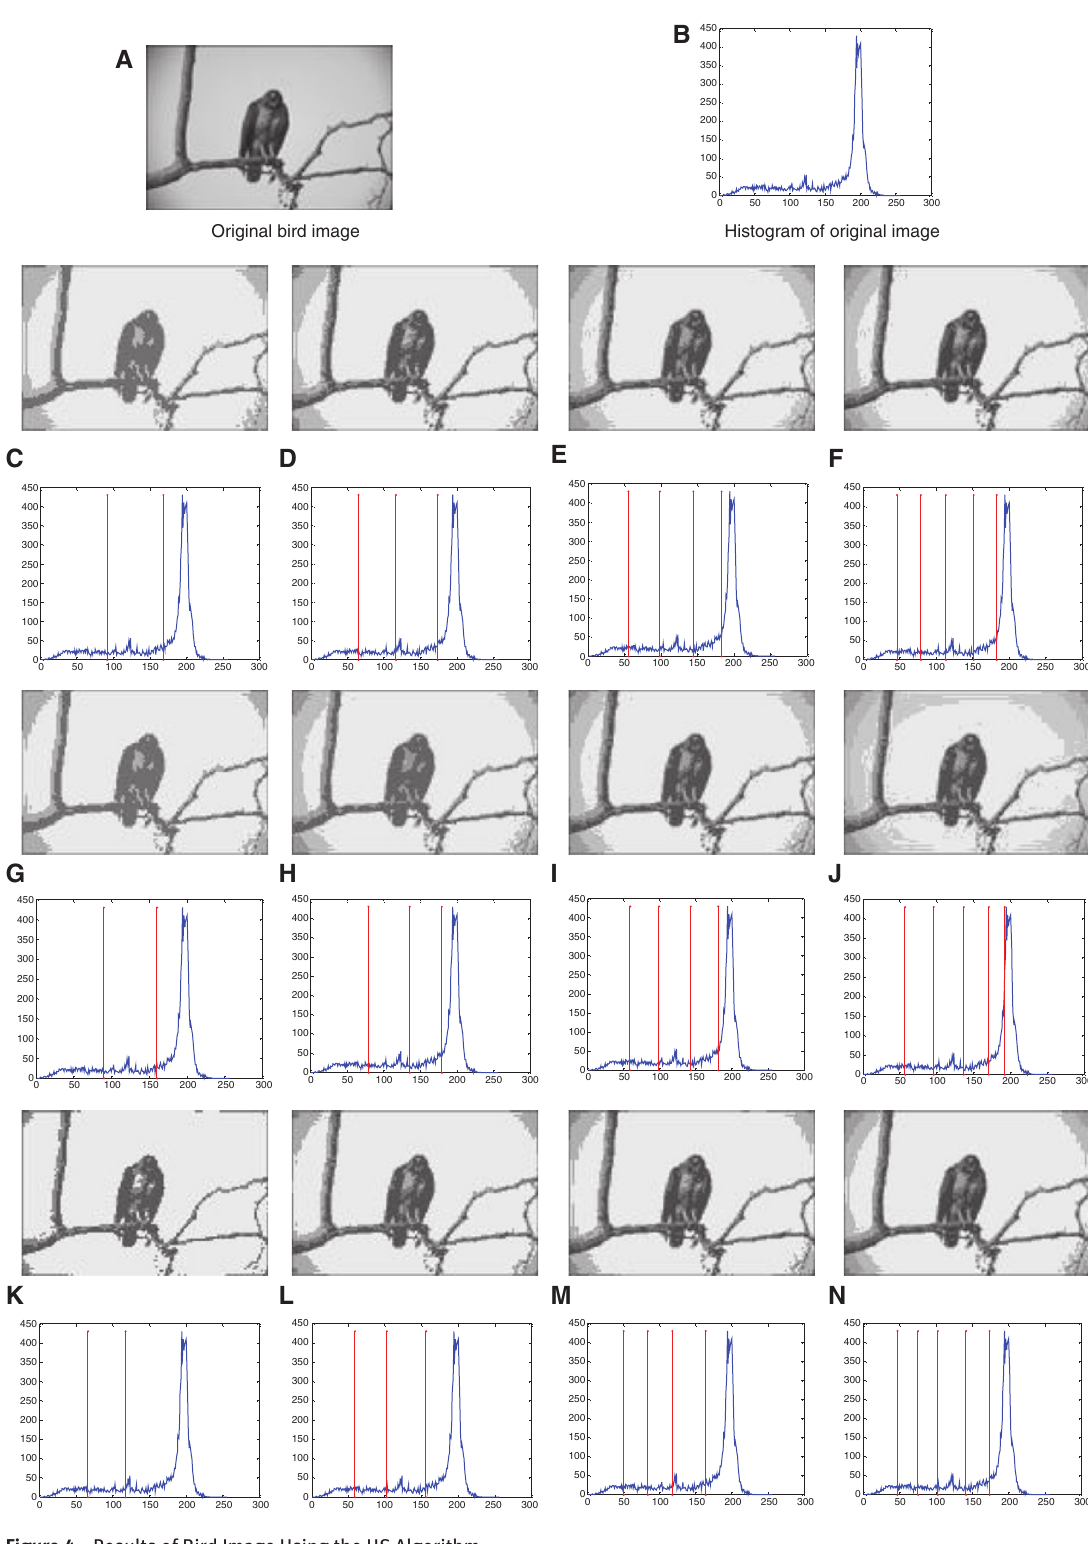
Figure 4: Results of Bird Image Using the HS Algorithm. (A) Original bird image, (B) histogram of original image, (C–F) two-level to five-level thresholding-based segmented image with the best thresholds obtained from the HS algorithm using Kapur’s entropy criterion, (G–J) two-level to five-level correspond- ing histogram labeled with the best threshold values obtained from the HS algorithm based on the between-class variance criterion, (K–N) two-level to five-level thresholding-based segmented image with the best thresholds obtained from the HS algorithm using Tsallis entropy